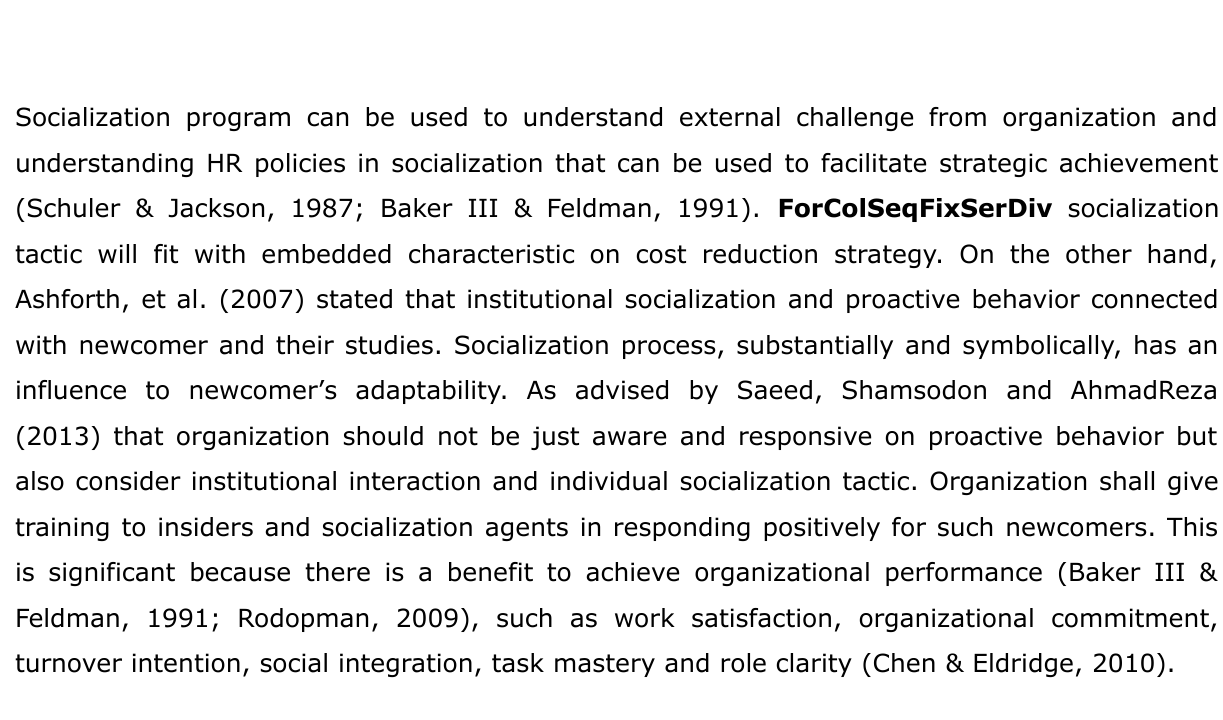
Table 3. Linking Socialization Tactics with Oganizational strategy (Baker III & Feldman,